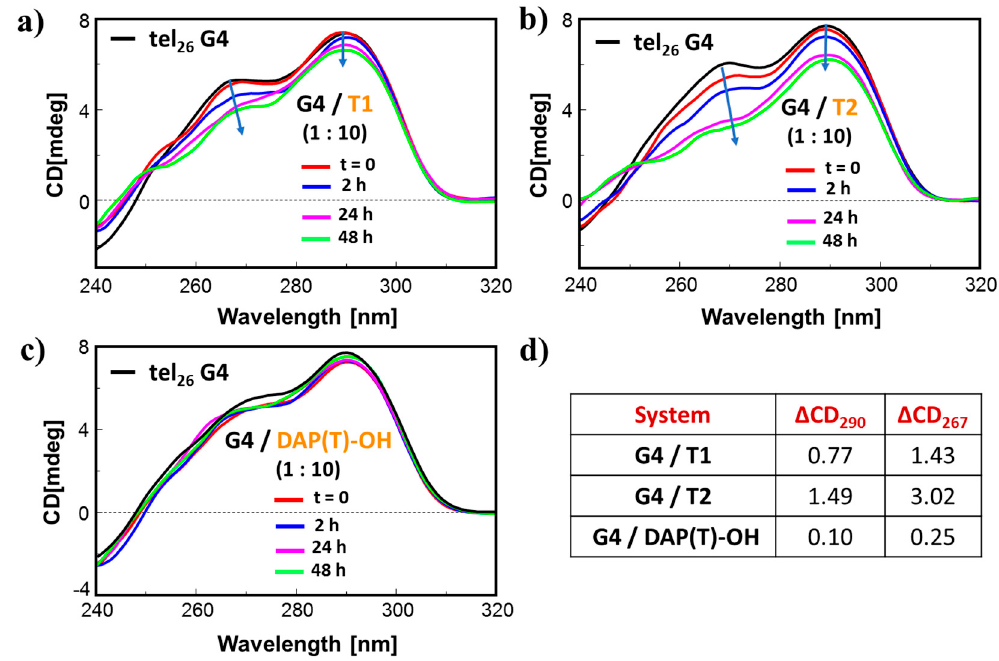
Figure 5. Overlapped CD spectra of the G-quadruplex (G4) tel 26 (2 μ M concentration), in the absence (black lines) and presence of T1 ( a ), T2 ( b ), and DAP(T)–OH ( c ) (20 μ M each) at different times (0, 2, 24, 48 h) after the addition of the target molecules. ( d ) Differences in the CD signal at 290 and 267 nm between the CD spectra of the G4, before and after 48 h incubation with each added compound. The experiments were carried out in 100 mM KCl, 7 mM Na 2 HPO 4 /NaH 2 PO 4 , pH = 7.2, at 20 °C (optical path = 1 cm).